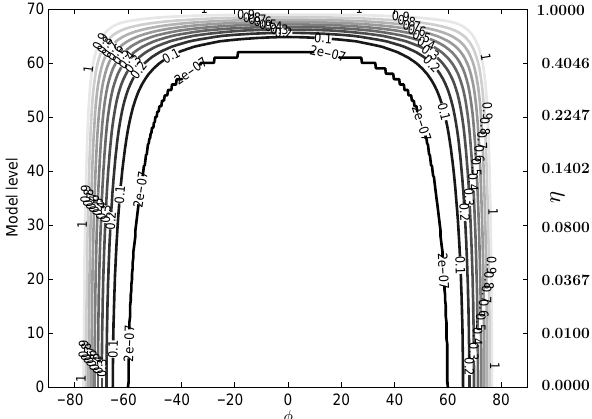
Figure 2. Implicit sponge layer µ(φ,η) as given by Eq. (6) with η B 1 / 2 and µ 1. Left axis shows model levels, using = = L70 ( 50 t , 20 s ) 80 , right axis shows computational η space (physical η height z ∼